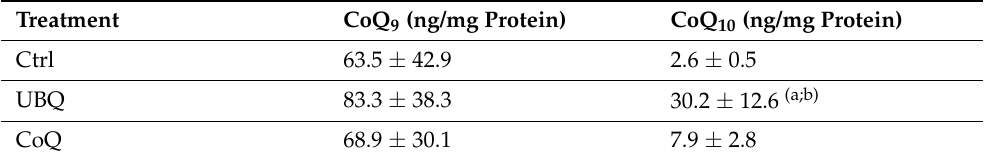
Table 1. CoQ 9 and CoQ 10 values (ng/mg protein) in mouse skeletal cells that were exposed to different treatments with pooled LDL extracted from volunteers who were supplemented with Ubiqsome (UBQ) and crystallized CoQ 10 (CoQ). a p < 0.0001 compared with the control; b p < 0.0001 compared with